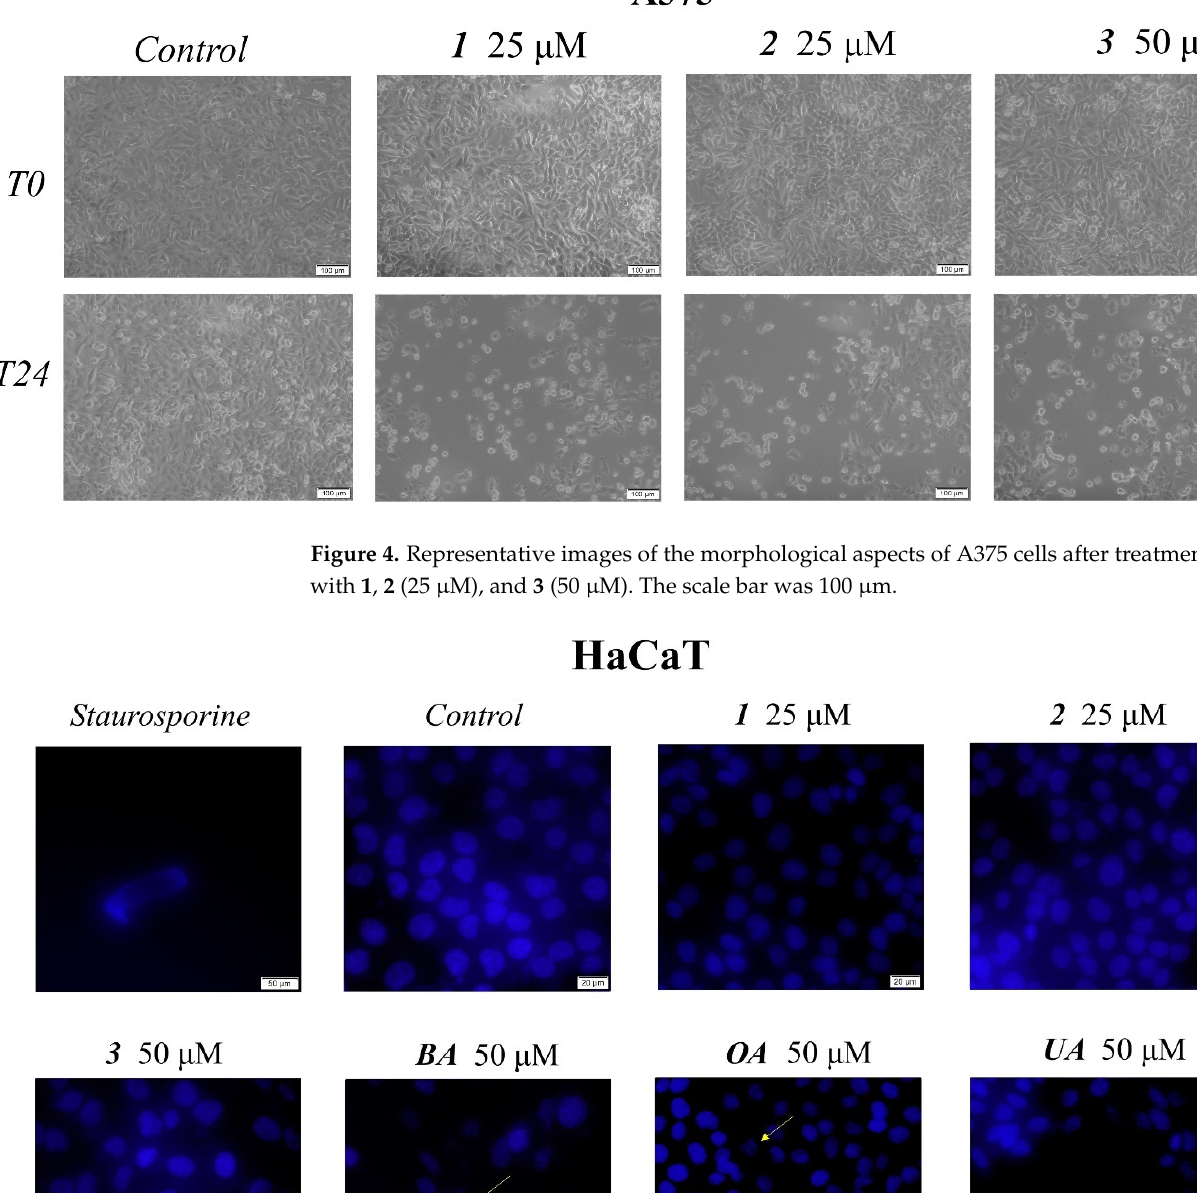
Figure 3. Representative images of the morphological aspects of HaCaT cells after treatment for 24 h with 1 , 2 (25 μ M), and 3 (50 μ M). The scale bar was 100 μ m.